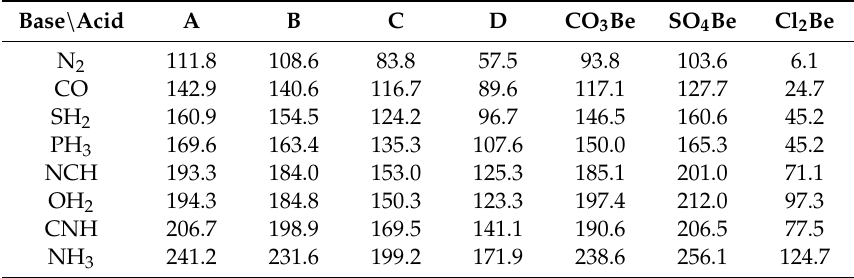
Table 3. Dissociation enthalpies (kJ · mol − 1 ) calculated at G4 computational